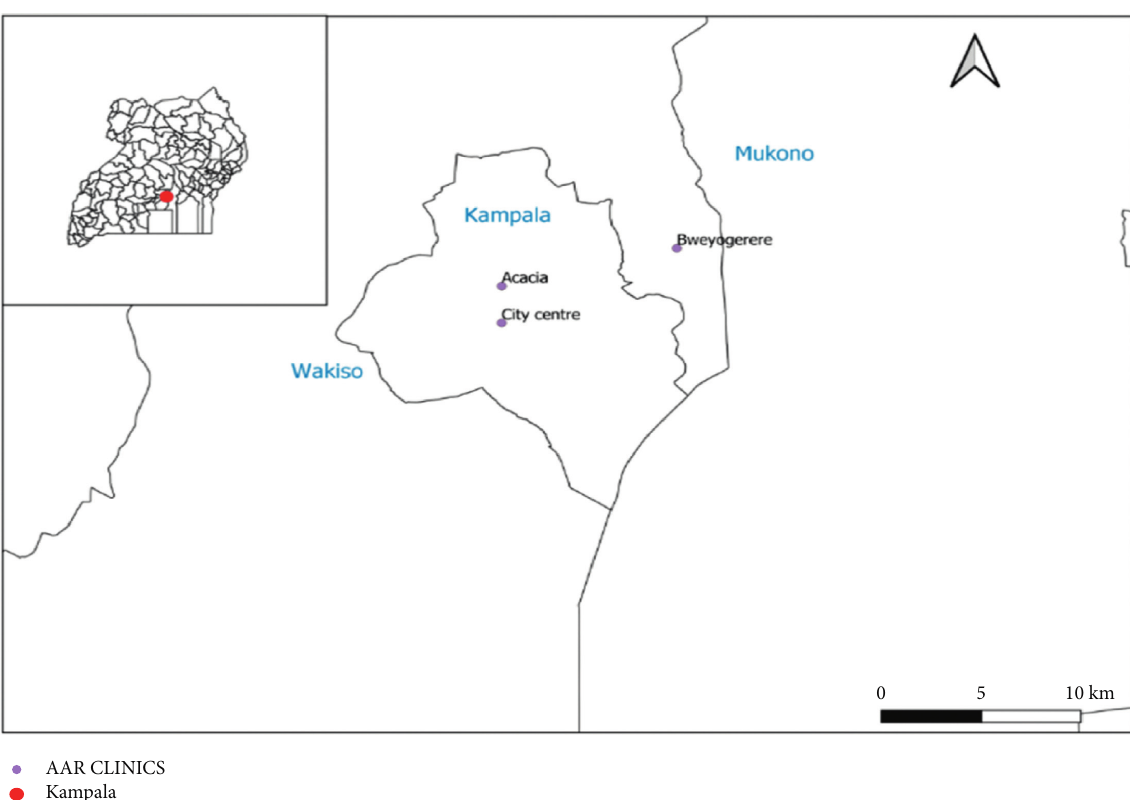
Figure 1: A map showing the location of study sites (inset is the map of Uganda). Note: this map was generated in QGIS as it cannot be changed to other editable